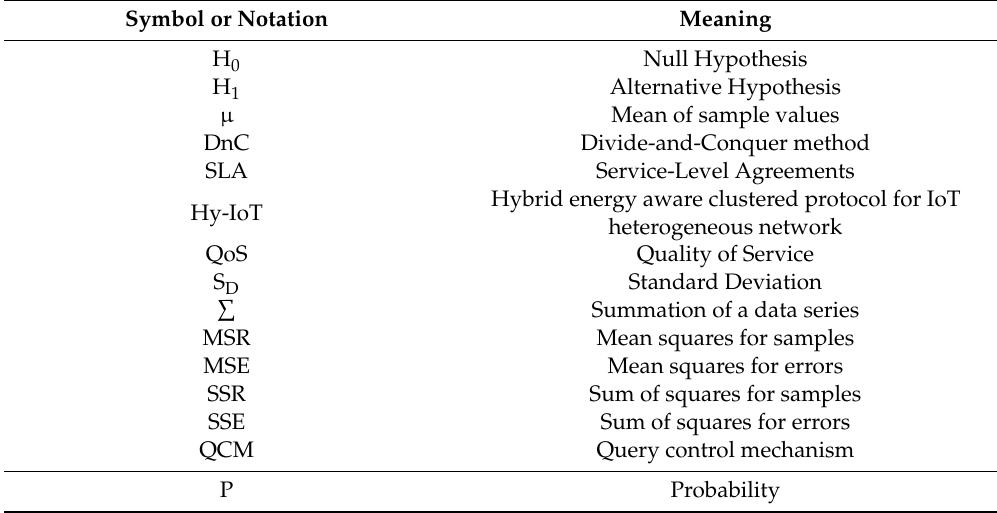
Table 1. Illustration of symbols and notations used in the